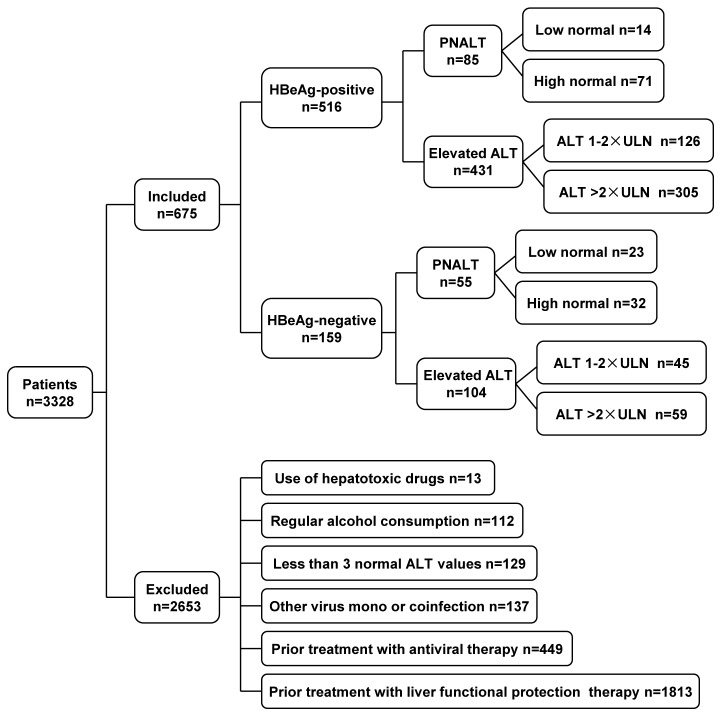
Flow chart of study design.We screened 3328 patients with liver biopsy from May 2005 to October 2011 and 675 met our inclusion criteria, 2653 patients were excluded. Among the included patients, 516 were HBeAg-positive patients (85 patients with PNALT and 431 with elevated ALT) and the remaining 159 were HBeAg-negative patients (55 with PNALT and 104 with elevated ALT).